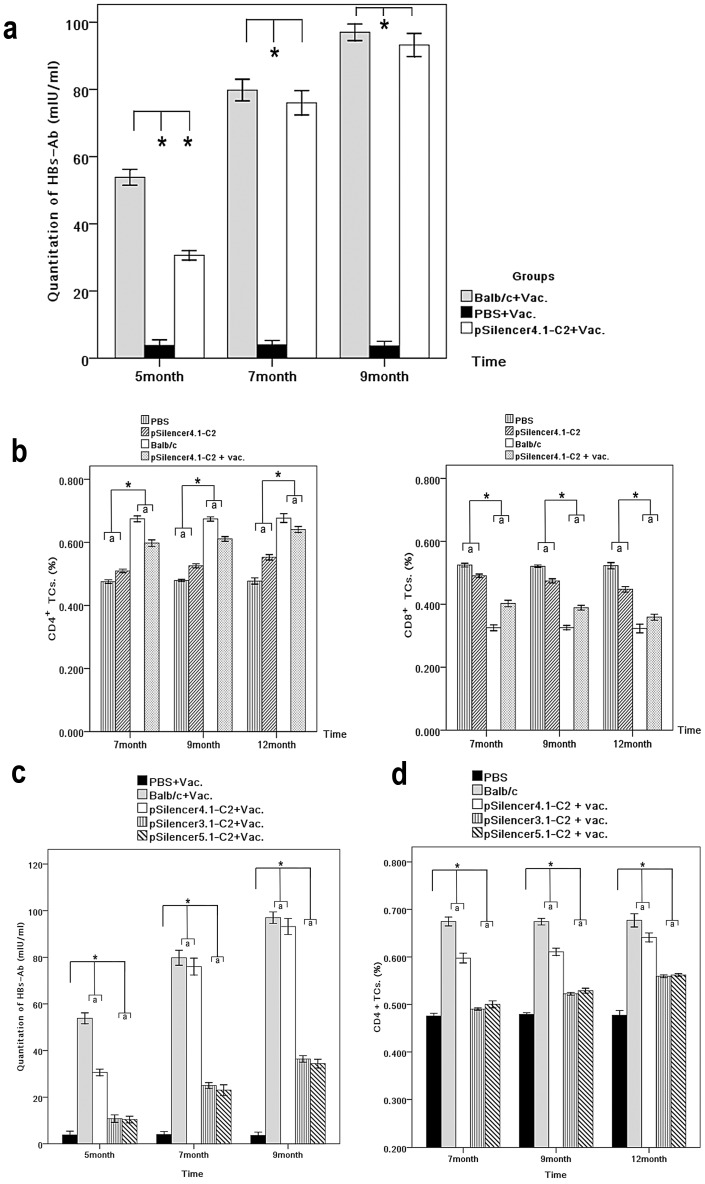
Immune tolerance rescue in the HBV transgenic mice after siRNA treated and vaccine.The Abbott MEIA quantitation of HBsAg-Ab in mouse serum was carried out among the pSilencer4.1-C2 treated transgenic mice, PBS injected transgenic mice and normal Balb/c mice after HBV vaccination (a). The mononuclear cells were stained with CD3, CD4 and CD8 specific abs. CD3 gated cells were examined for CD4 and CD8 expression. The graph indicates the effect of pSilencer4.1-C2 and vaccination on the changes of CD4+ and CD8+ T cells in the liver samples of transgenic mice (b). The CD4+ T cells count (c) and HBsAg-Ab titers quantitation (d) were measured by flow cytometry and MEIA respectively, and figures showed their difference expressions among three kinds of siRNA vector treated transgenic mice after HBV vaccination. The symbol ‘a’ in the brackets indicate no differences between two groups. n = 6–8 mice per group. Balb/c mice, normal mice; PBS, phosphate-buffered saline; vac., vaccination. (*: p<0.05, a: p>0.05).